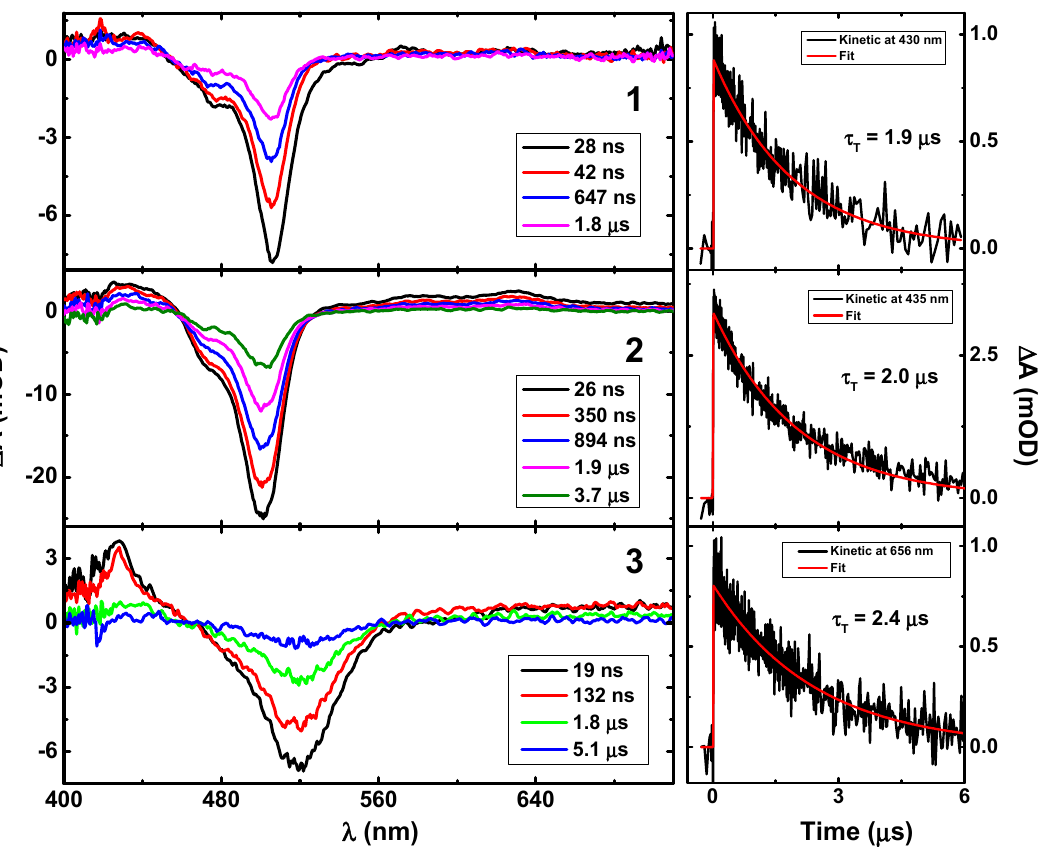
Figure 2. Room temperature time-resolved triplet-singlet difference absorption spectra together with the characteristic kinetic traces and triplet lifetimes for BODIPY 1 – 3 in deaerated tetrahydrofuran solutions collected with excitation at 370 nm.